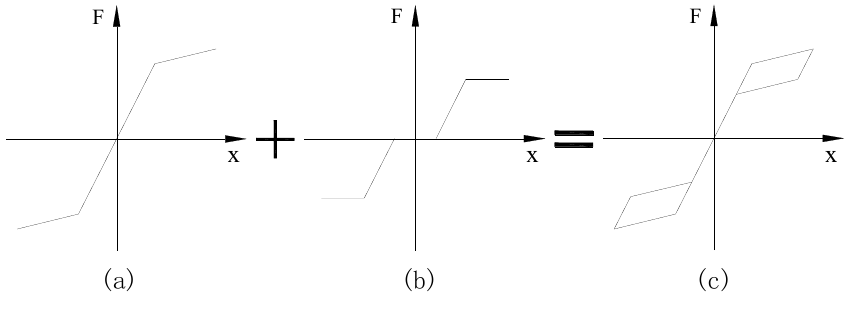
Figure 19. SMA cable overlay.